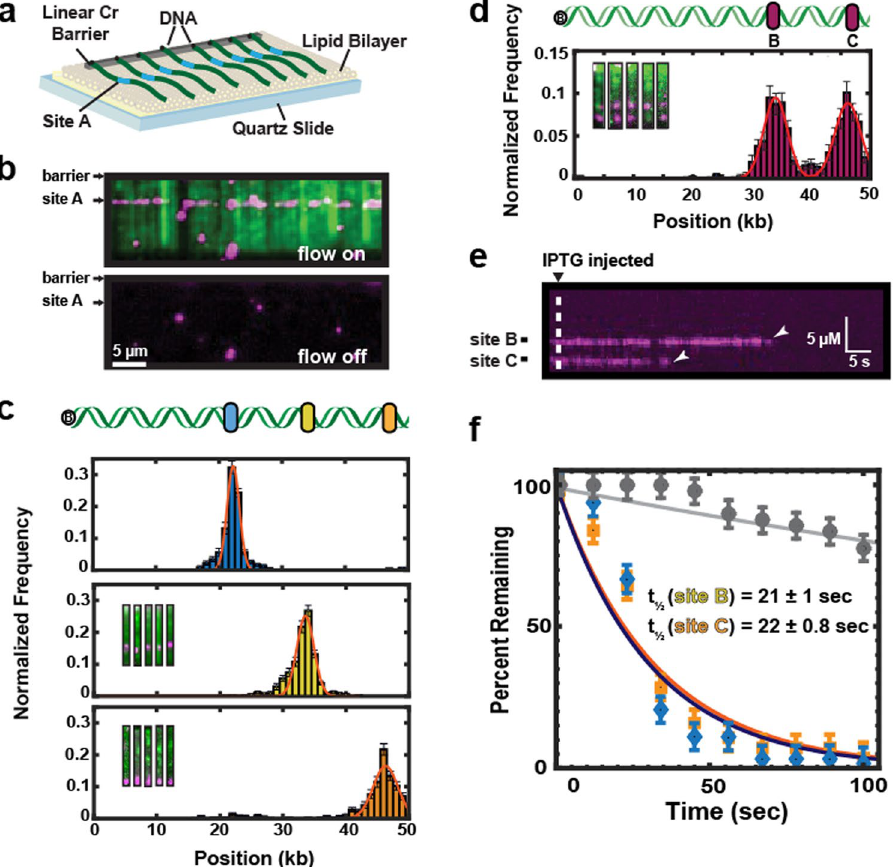
Figure 2. Single-molecule imaging of Lac repressor (LacI) dynamics on recombineered λ - DNA substrates. ( a ) Schematic of a single-tethered DNA curtain assay. DNA molecules (green) are immobilized on a fluid lipid bilayer and arranged at micro-fabricated Chromium (Cr) barriers. One of the insertion sites (site A) is indicated in blue. ( b ) TIRFM image of LacI (magenta) binding to a lac operator inserted at site A on a recombineered λ -DNA substrate (green). ( c ) Binding distributions of LacI to a lac operator sequence inserted at one of the three sites within λ -DNA. Solid lines indicate a Gaussian fit to the data with the indicated mean ± standard deviation. Blue: site A (21.7 ± 1.0 kb, N = 558, blue). Yellow: site B (34.0 ± 1.5 kb, mean N = 538). Orange: site C (46.0 ± 2.3 kb, N = 467). ( d ) Insertion of two lac operator cassettes within a single λ -DNA construct. Inset: single-molecule imaging of the recombinant DNA shows LacI at both positions B & C. Binding histograms show nearly equal occupancy at both lac operator sites. Red line: double Gaussian fit (34.0 ± 2.0 kb and 46.2 ± 2.2 kb, respectively; N = 525). ( e ) As expected, LacI dissociates from both operator sites after injection of 0.4 mM Isopropyl β -D-1-thiogalactopyranoside (IPTG). ( f ) Quantification of the LacI lifetimes upon IPTG injection. The solid lines are single-exponential fits to the data (blue diamonds, t ½ = 21 ± 1.0 sec, N = 63, and orange squares, t ½ = 22 ± 0.8 sec, N = 56 at positions B & C, respectfully). The solid gray line is the single- exponential fit of the LacI lifetime data, in the absence of IPTG (grey circles, t ½ = 327 ± 10 s, N = 49). The error bars indicate the standard deviation obtained via bootstrap